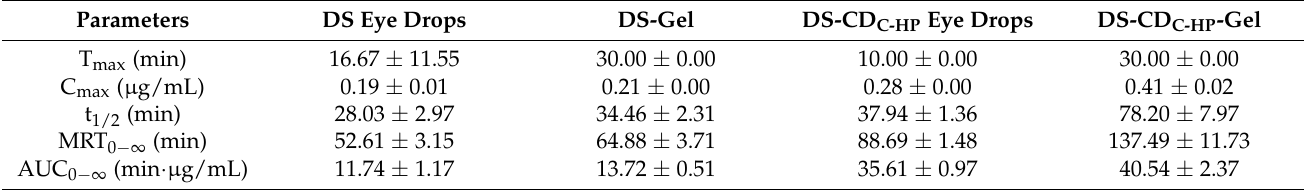
Table 2. Pharmacokinetic parameters of DS in the aqueous humor of rabbits (n =